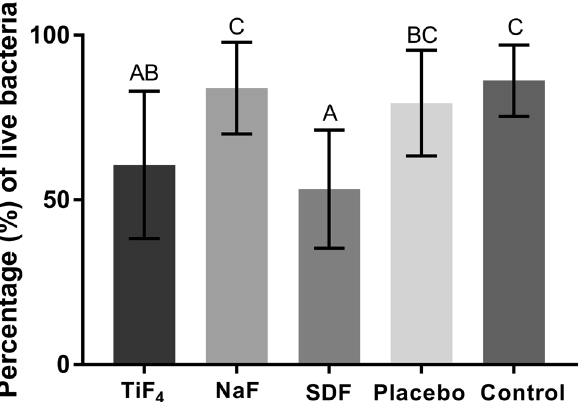
Figure 2. Mean and standard deviation of the percentage of live bacteria (%). Different letters show significant differences among the treatments. ANOVA/ Tukey–Kramer test ( p < 0.0001).